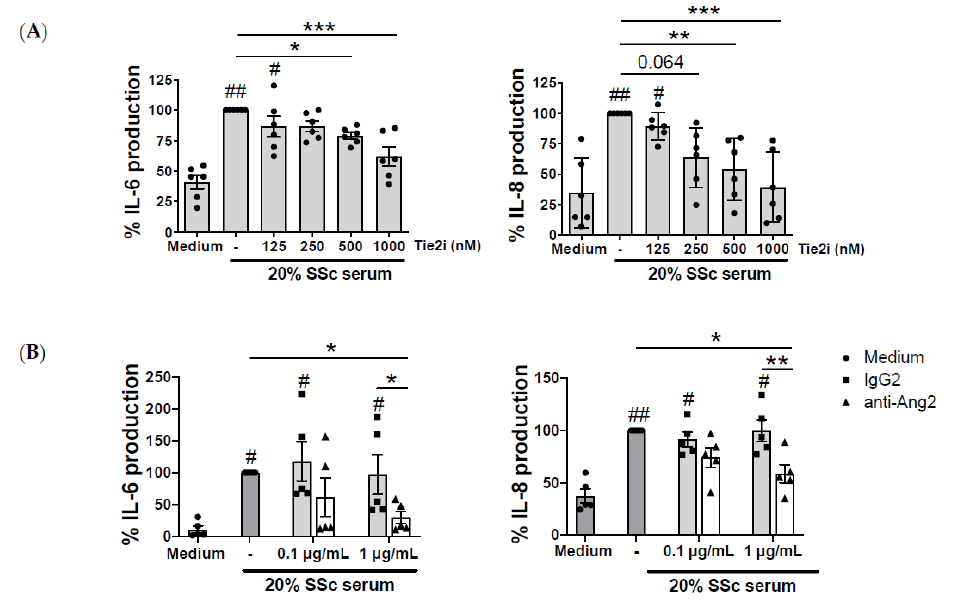
Figure 4. Tie2 inhibition and Ang-2 neutralization reduce the systemic sclerosis serum-induced monocyte IL-6 and IL-8 production. ( A ) IL-6 and IL-8 production by HC monocytes, pre-treated for 1 h with increasing concentrations of Tie2 inhibitor (Tie2i) and stimulated for 24 h with serum of SSc patients (20% v / v ). Data are presented as a percentage of production relative to SSc serum from 5 independent experiments. ( B ) IL-6 and IL-8 production by HC monocytes after 24-h incubation with the serum of SSc patients (20% v / v ), pre-treated for 1 h with an isotype control (IgG2) or an anti-Ang-2 neutralizing antibody. Data are presented as a percentage of production relative to SSc serum, from 6 independent experiments. Means and SEM are shown. * p < 0.05, ** p < 0.01 and *** p < 0.001. # p < 0.05 and ## p < 0.01 compared to medium.